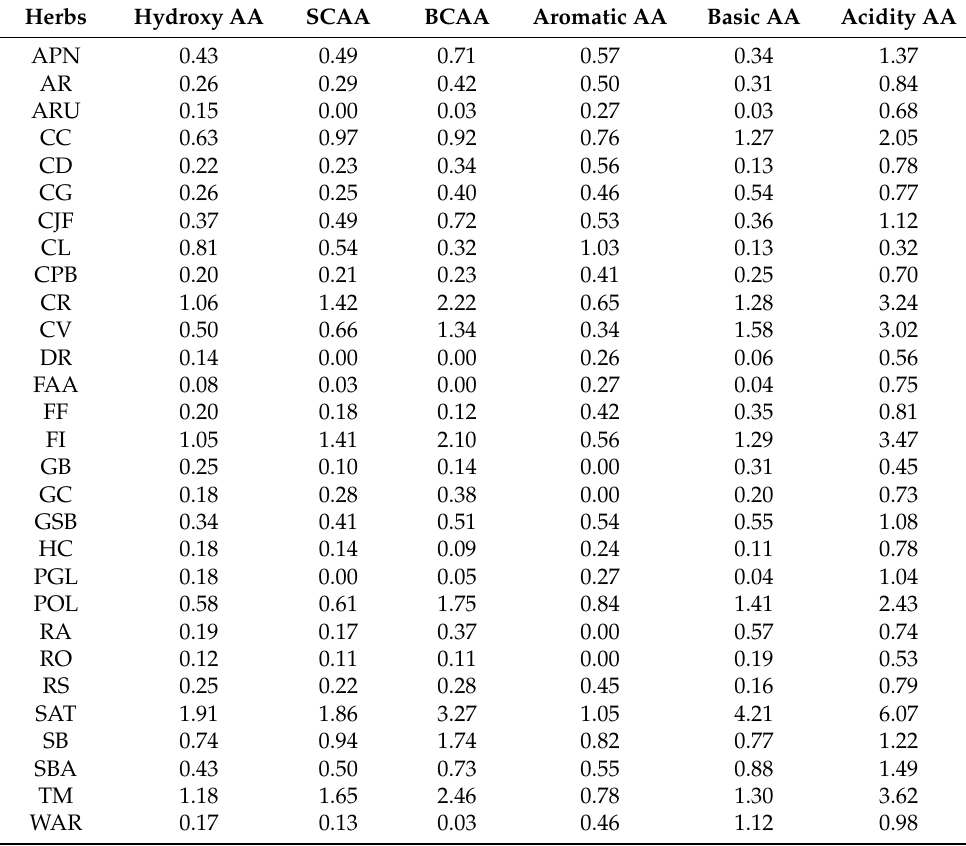
Table 4. Classified amino acids (AAs) contents of 29 different Chinese herbs (mg/g).